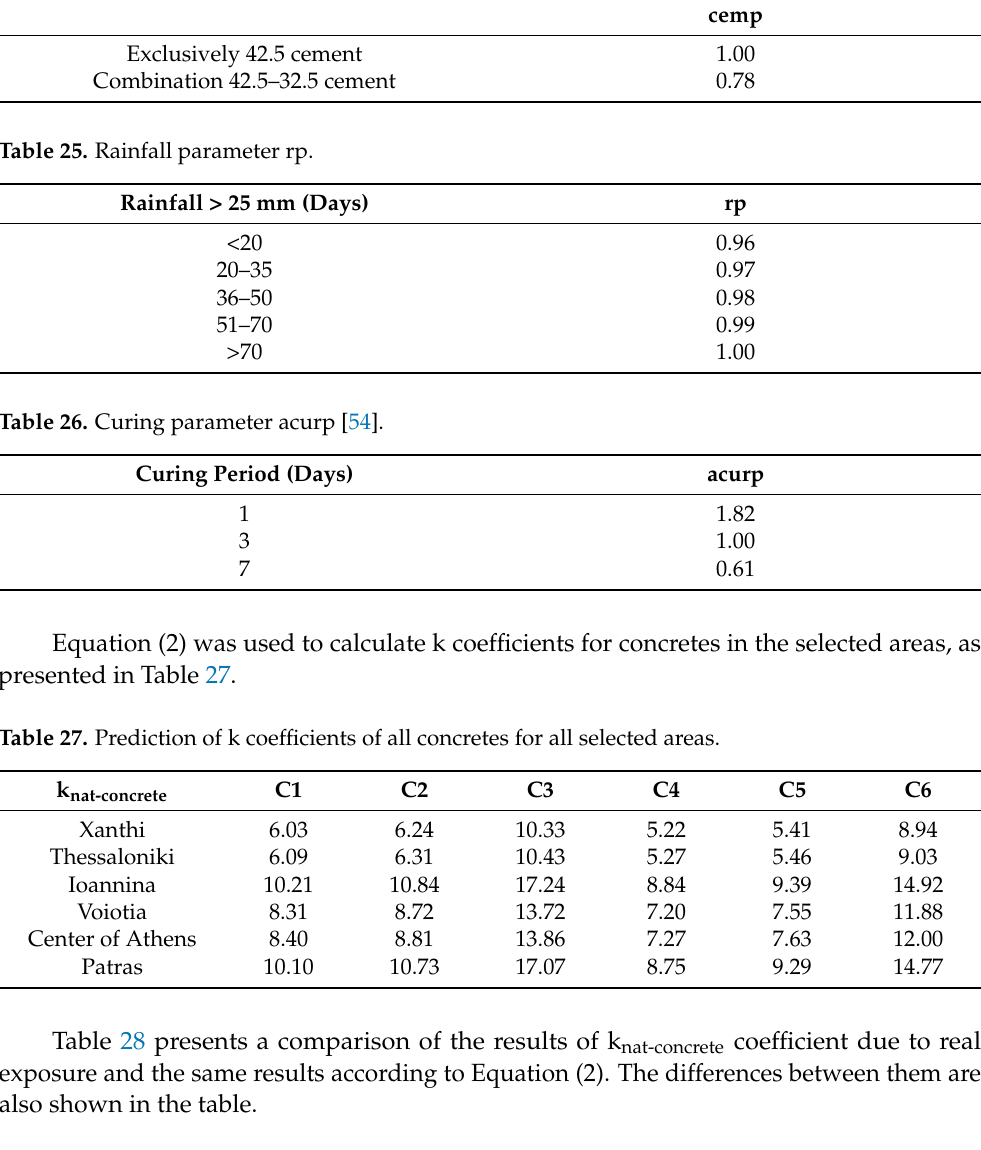
Table 28. k nat-concrete values of real exposure and prediction